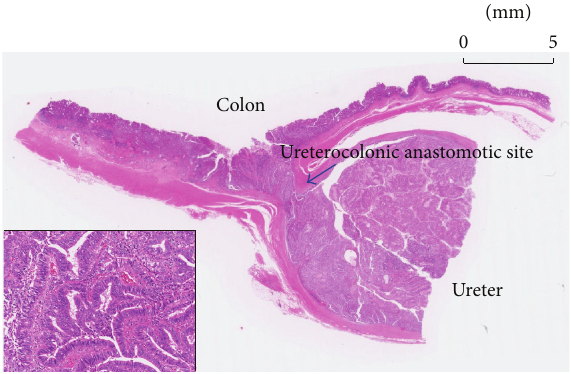
Figure 1: Histology of the left anastomotic site. The tumor spread around the sigmoid colon and ureter, which made the origin of tumor undetermined.